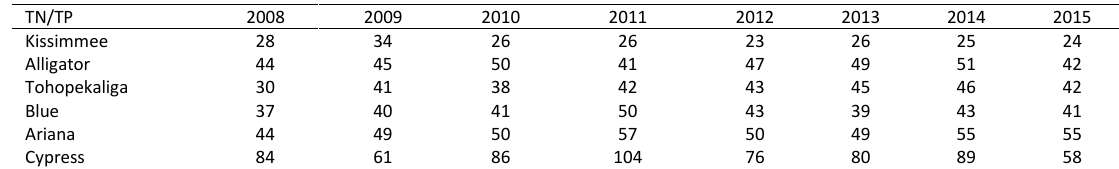
Table 3: Correlation between TN/TP